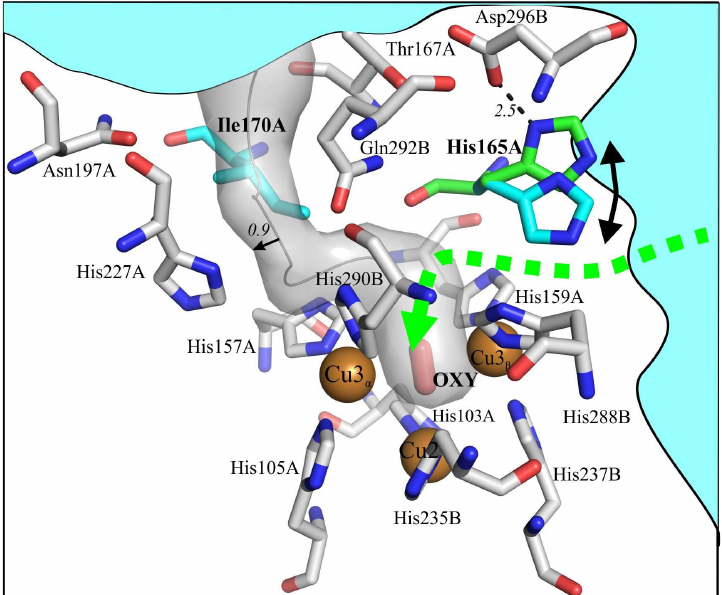
Figure 1. Estimated oxygen tunnels in the SgflSL WT (PDB entry 5LHL). The calculated trajectory of the T3 α tunnel behind Ile170 is shown in gray. The trajectory of the T3 β tunnel, for which His165 serves as the “gateway”, is green. The side chains of His165 is blue in the structure (“close” state) and green in possible open position. OXY – dioxigen. The distances are shown in angstroms. Bulk solvent is shown in cyan. Chains A and B belong to the neighboring monomer.